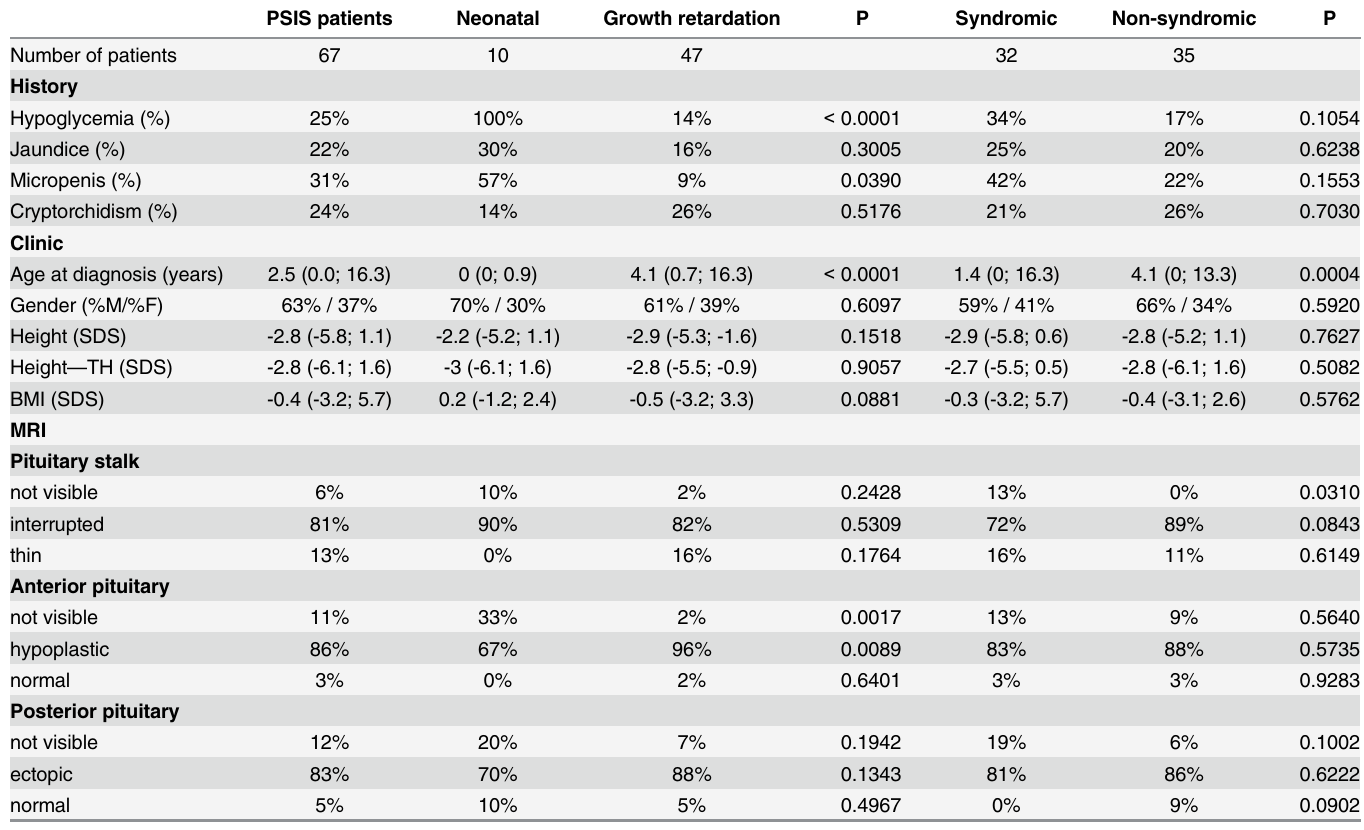
Table 1. Clinical and radiological characteristics at baseline of the 67 patients with PSIS and the